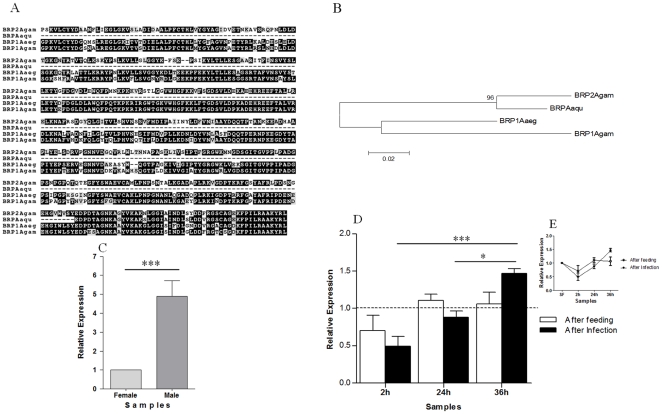
Characterization of BRP related protein induction in mosquitoes fed on sugar, blood, or infected blood.A: Multiple aminoacid sequence alignment of mosquito BRPs. B: Phylogenetic tree for BRP sequences based on the neighbor-joining method. C–E: Expression levels of BRP determined by RTPCR following various feeding regimens. C: Sugar-fed males and females, D and E: sugar-fed (dotted line and SF), blood-fed (AF) and P. vivax infected (AI) females. h–hours. Accession numbers of BRP sequences from: A. aquasalis (Aaqu) (GR486800); A. gambiae (Agam) (BRP1 - AGAP008061 and BRP2 - AGAP008060) and A. aegypti (Aaeg) (BRP1 - AAEL001965). +−: s.e.m.; * p<0.05, ** 0.03>p>0.01, *** p<0.01.